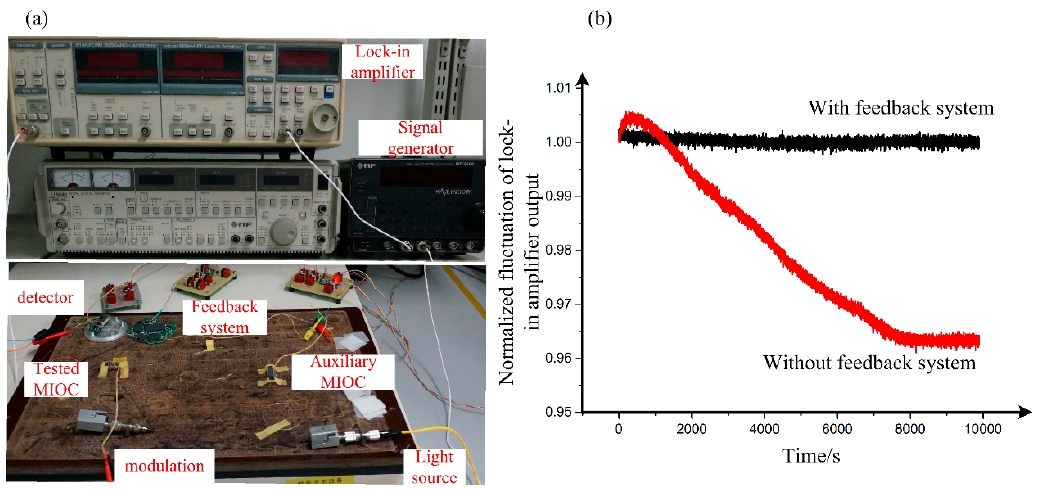
Figure 3. ( a ) Measurement setup for the halfwave voltage as a function of frequency; ( b ) normalized output of lock-in amplifier with and without the feedback system.